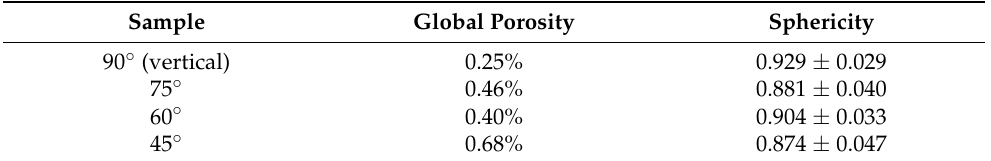
Table 6. Results from the µCT